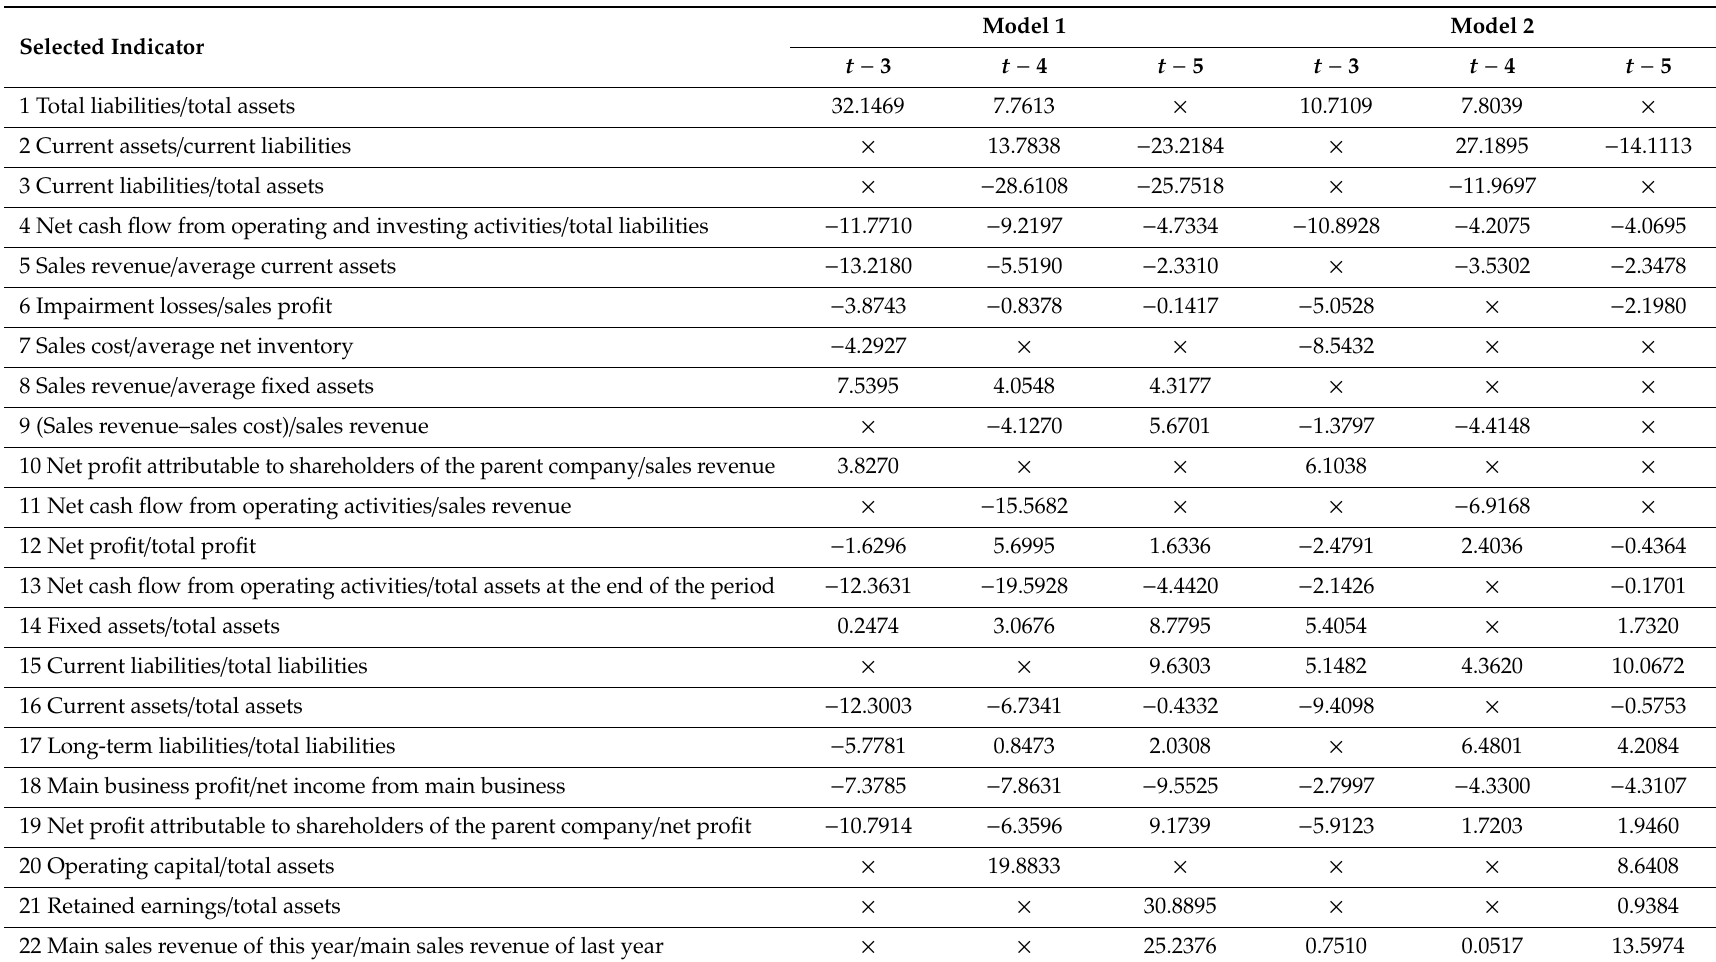
Table 4. The indicator selection and the estimates for the lasso–SVM-distributed lag